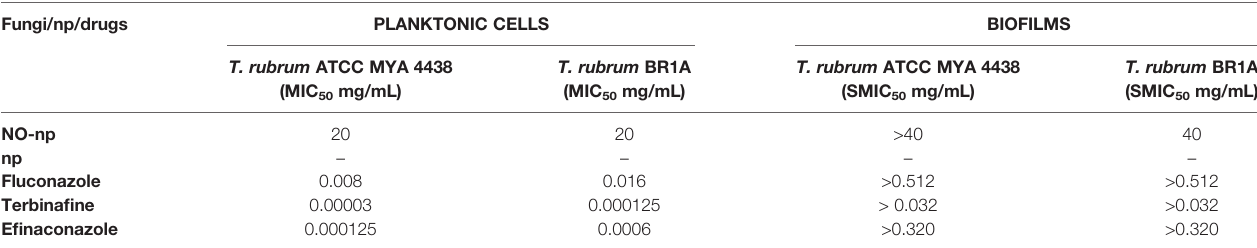
TABLE 1 | Susceptibility of T. rubrum ATCC MYA 4438 or BR1A planktonic cells or bio fi lms to nitric oxide nanoparticles (NO-np), control nanoparticles (np), fl uconazole (FCZ), terbina fi ne (TRB), or e fi naconazole (EFCZ).